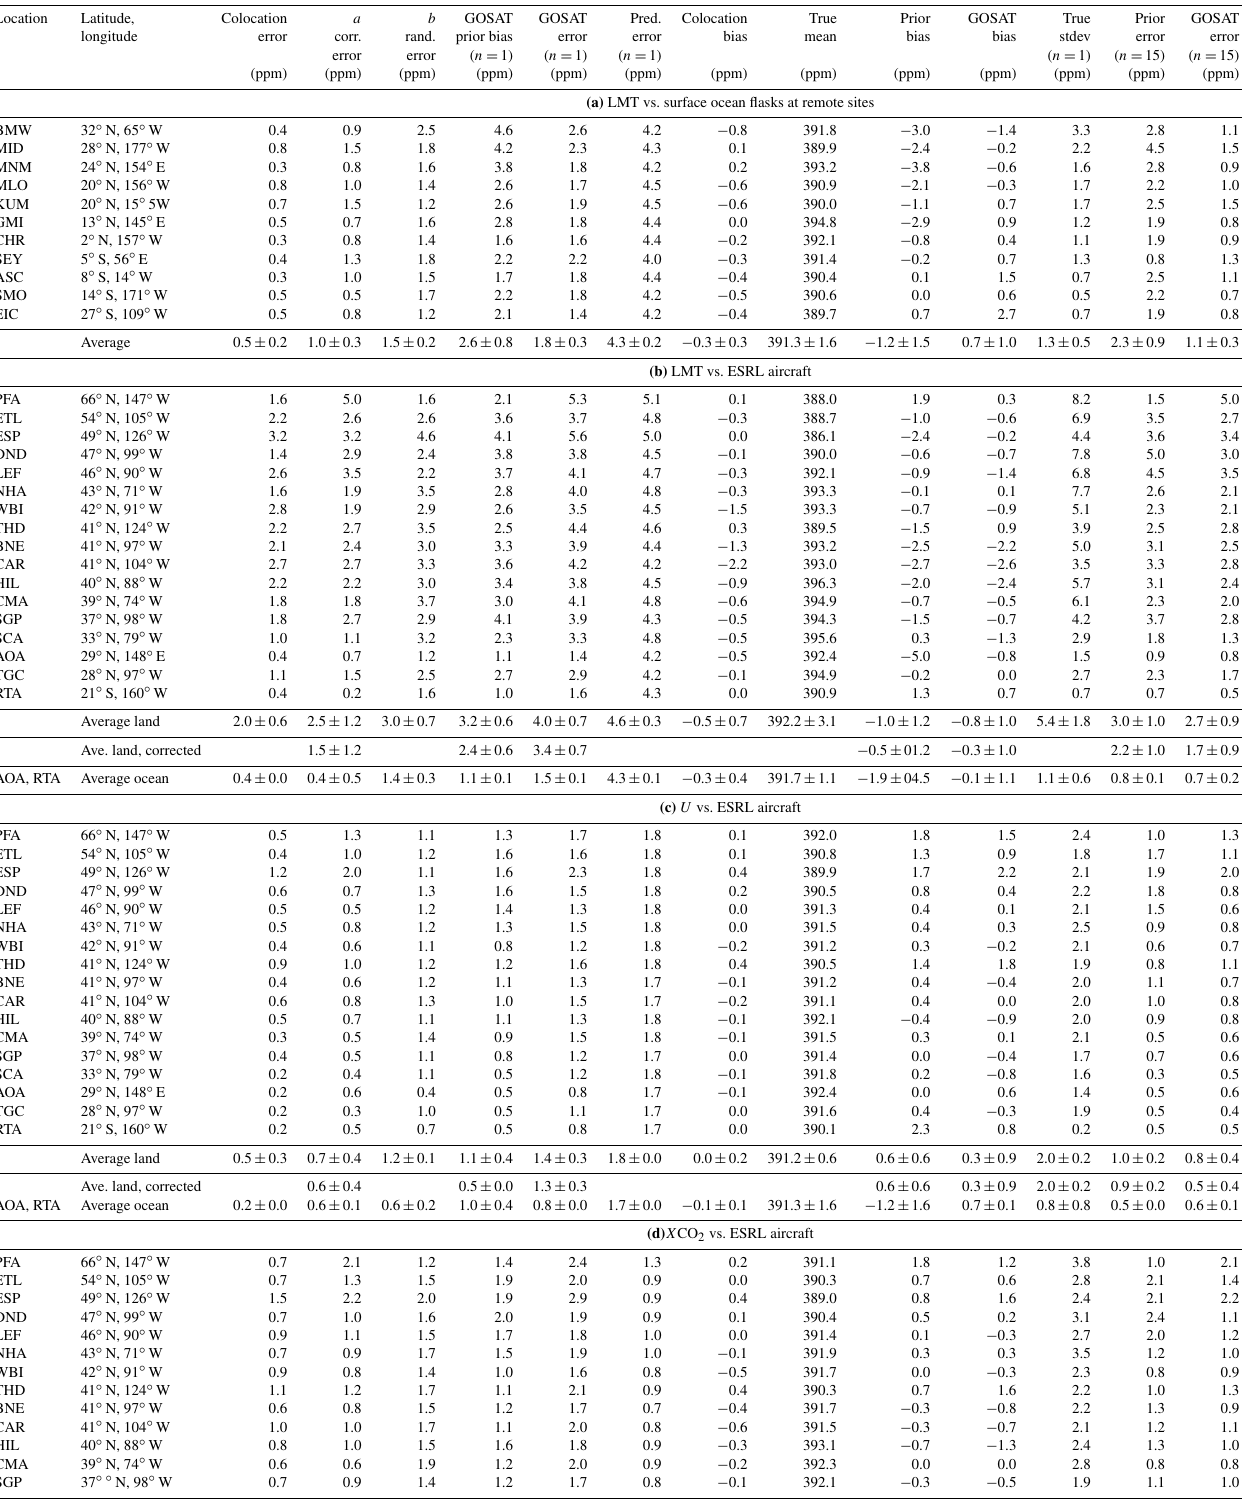
Table B1. Actual and predictions of errors by station and campaign. See Table 3 for definitions of the quantities calculated in Table B1. Location Latitude, Colocation a b GOSAT GOSAT Pred. Colocation True GOSAT longitude error (a) LMT vs. surface ocean flasks at remote sites